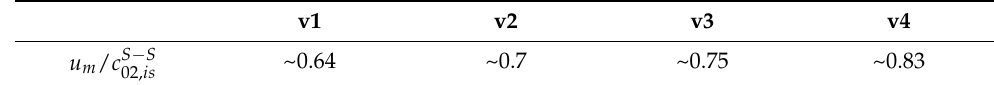
Table 2. Designation of calculated turbine stage modes.